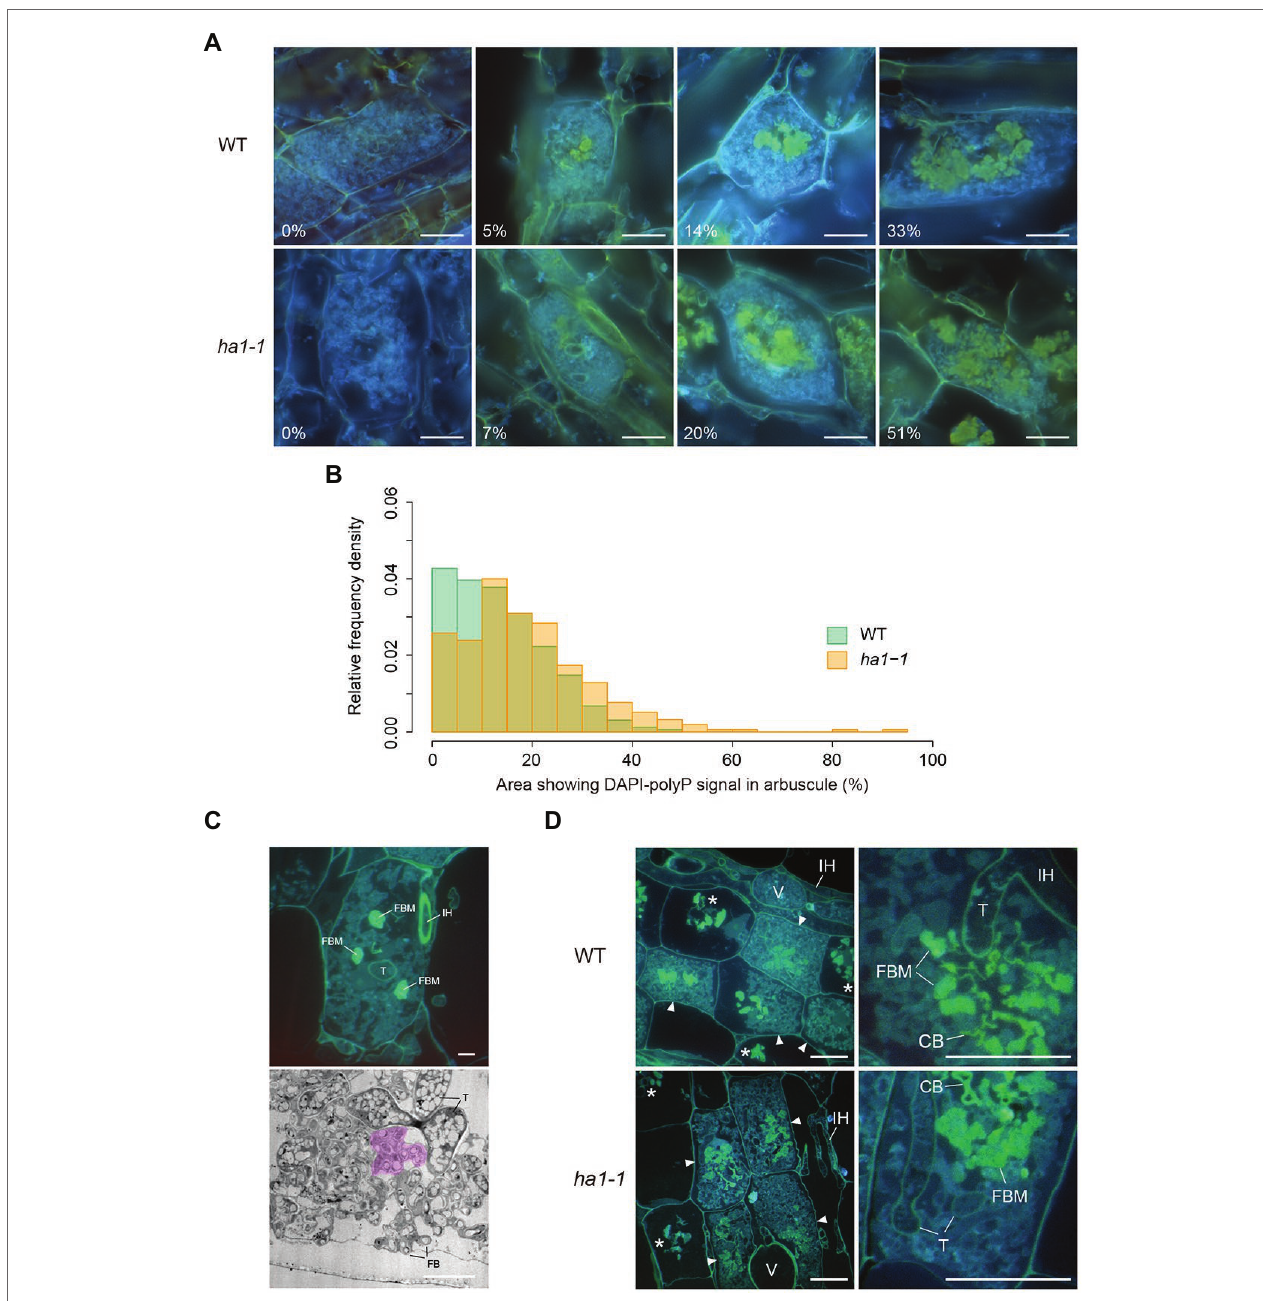
FIGURE 3 | Localization of polyphosphate (polyP) by DAPI staining. (A) Representative types of mature arbuscules stained with DAPI. Mycorrhizal roots of L. japonicus were harvested 4 weeks after inoculation with R. irregularis . Yellow fluorescence is observed in the central part of arbuscules. Percentages of arbuscule area showing yellow fluorescence signals are shown. Scale bars = 20 μ M. (B) Relative frequency density of the area showing DAPI-polyP signal. The percentage of arbuscule area with signal was calculated. In total, 323 and 310 mature arbuscules were measured for wild-type (WT) and ha1-1 , respectively. According to the two-sample Kolmogorov–Smirnov test, the size distribution was significantly different between the plant genotypes ( p < 0.001). (C) Fine branch modules (FBM) in arbuscules. In the upper panel, semithin sections of mature arbuscules in resin-embedded WT roots were stained with DAPI and observed using an epifluorescence microscope. Strong yellow fluorescence was observed in several fine branch modules, a set of connected fine branches. The lower panel shows a transmission electron micrograph of fine branches and trunk hyphae of an arbuscule colonized in a WT cortical cell. Acid phosphatase (ACP) activity was detected by electron microscopic enzyme cytochemistry as black precipitates of the reaction product (cerium phosphate). The region colored in magenta is a putative FBM in which fine branches form a cluster. FB: fine branch, FBM: fine branch module, IH: intraradical hypha, T: trunk hypha. Scale bars = 5 μ M. (D) DAPI staining of semithin sections of resin-embedded mycorrhizal roots. In the left panels, mature arbuscules (arrowheads) and degenerating arbuscules (asterisks) are shown. Right panels show magnified images of mature arbuscules. Fine branch modules (clusters of connected branches), trunk hyphae cell walls, and collapsed branches display yellow fluorescence. CB: collapsed branch, FBM: fine branch module, IH: intraradical hypha, T: trunk hypha, and V: vesicle. Scale bars = 20 μ